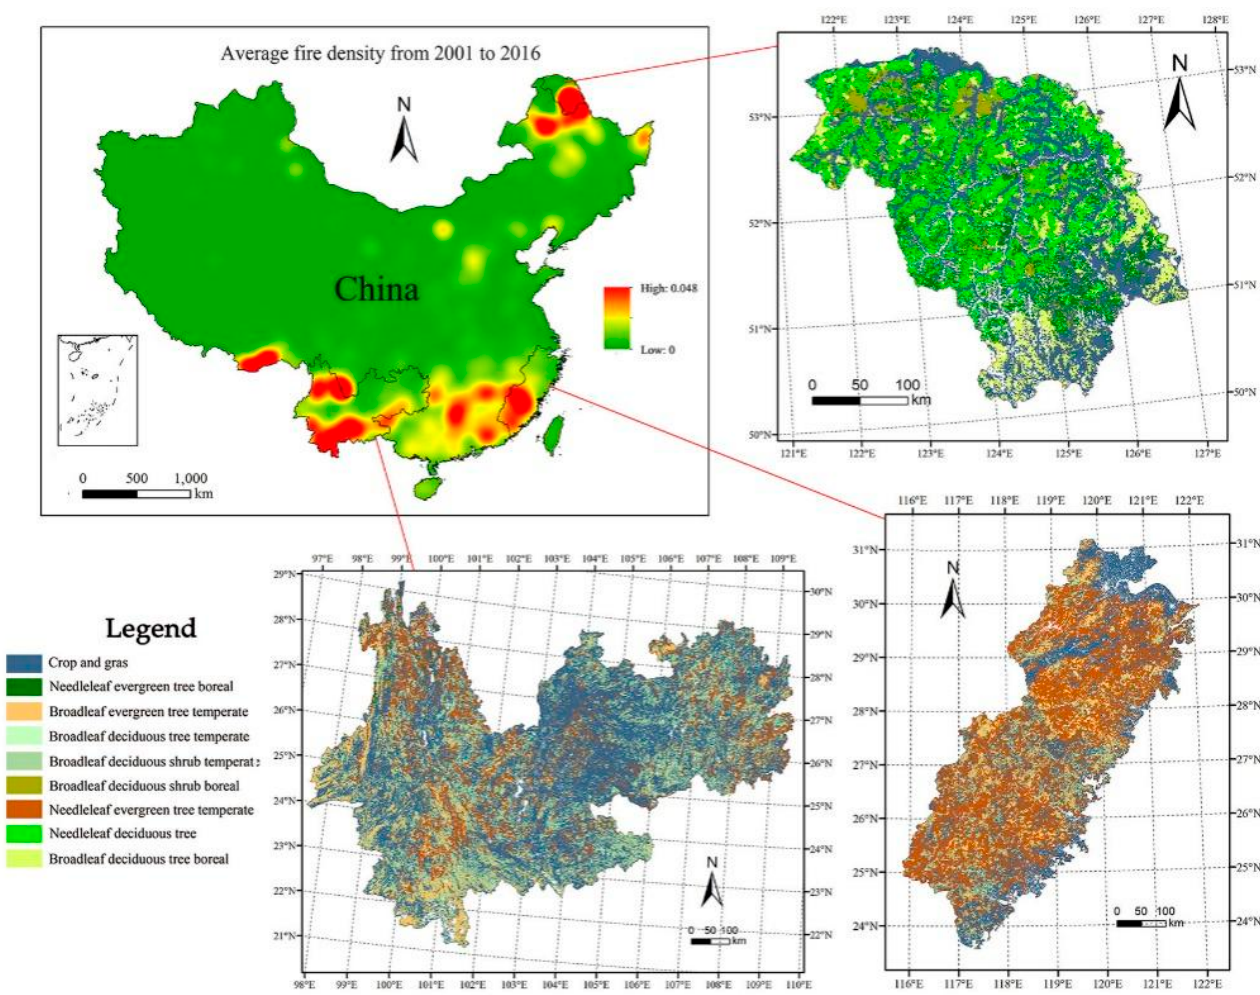
Figure 1. Active fire density in each study areas (NE, SW, and SE) from 2001 to 2016 and its spatial distribution of land fires derived from the resources and environment science data center, Chinese Academy of Sciences